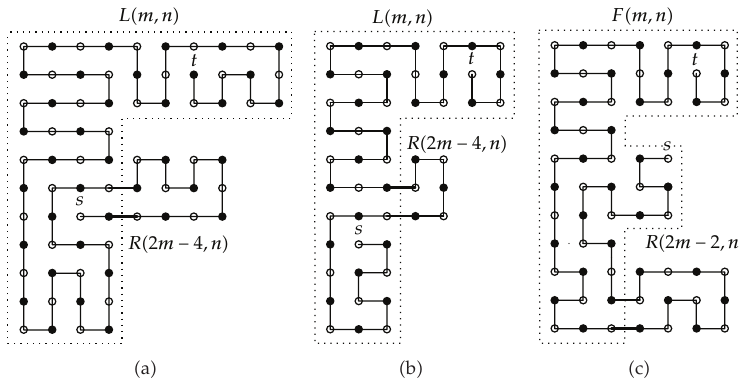
Figure 13: (cid:6) a (cid:7) , (cid:6) b (cid:7) A strip of F (cid:6) 4 , 3 (cid:7) and F (cid:6) 3 , 3 (cid:7) , (cid:6) c (cid:7) a strip of E (cid:6) 3 , 3 (cid:7) .